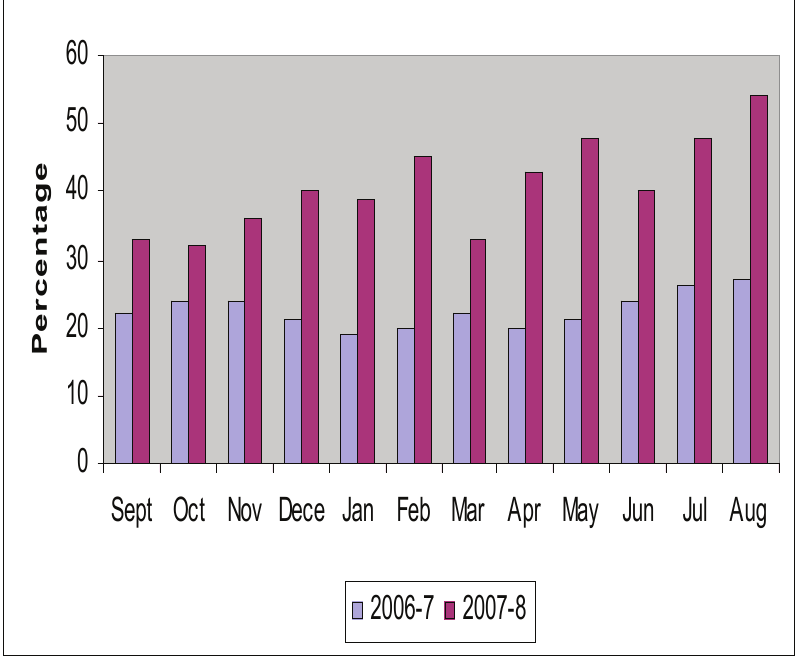
Figure 4: Comparison of 2006-7 & 2007-8 pass rates (Eastlea depot)